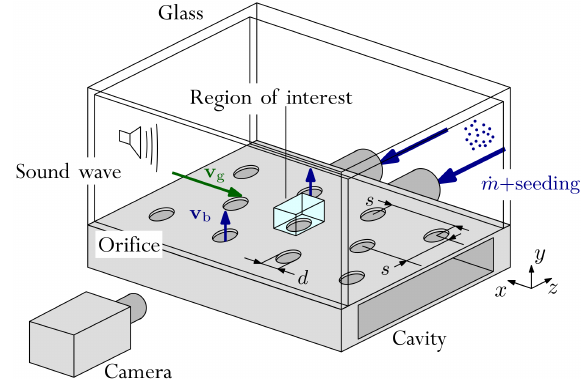
Figure 3. Bias flow liner test rig: a sound wave is excited above the liner facing sheet and is oriented in the direction of the super- imposed grazing flow with the velocity v g . Behind the perforated facing sheet is a cavity, in which an additional mass flow ˙ m is fed that provides the bias flow with the velocity v b through the perfora- tion of the liner. Note that the point of origin of the used coordinate system is located right in the centre of the